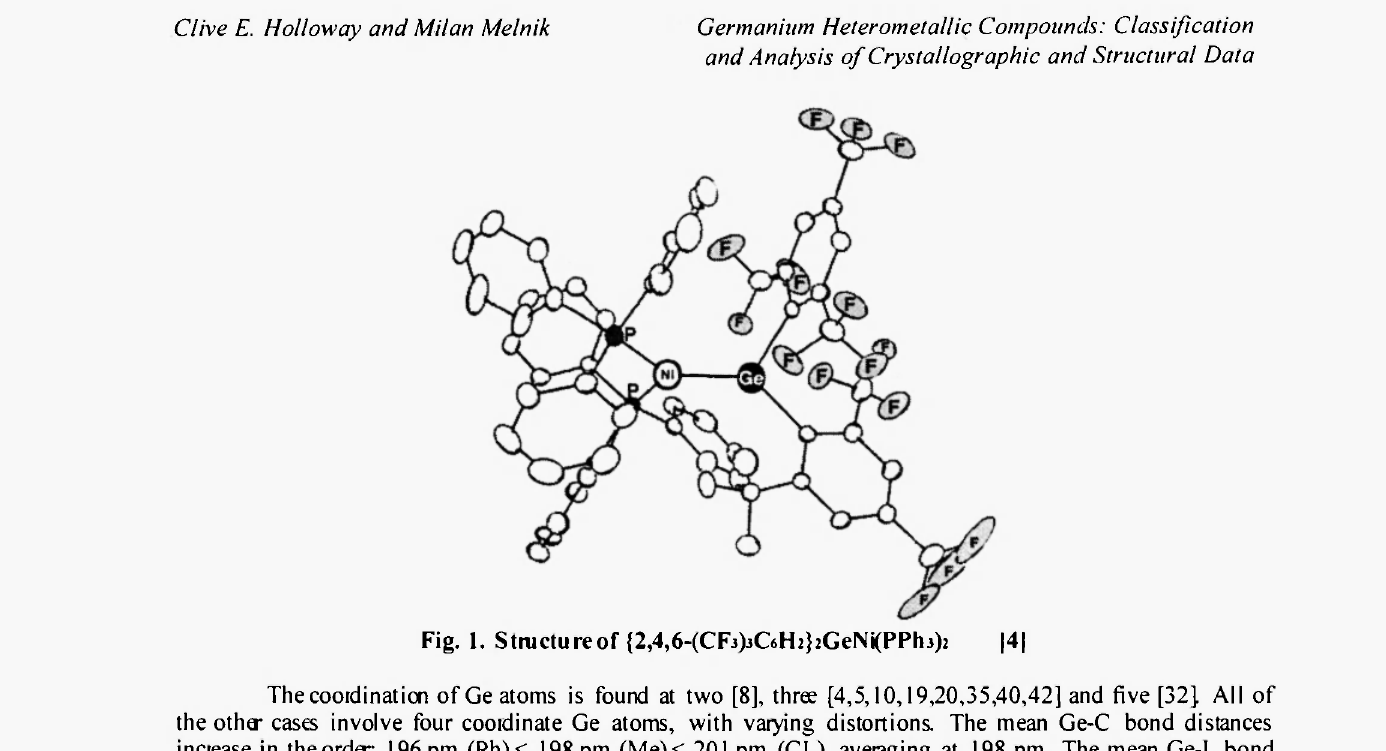
Fig. 1. Stmctureof {2,4,6-(CF3)3C6H 2 } 2 GeNKPPhj)2 |4|